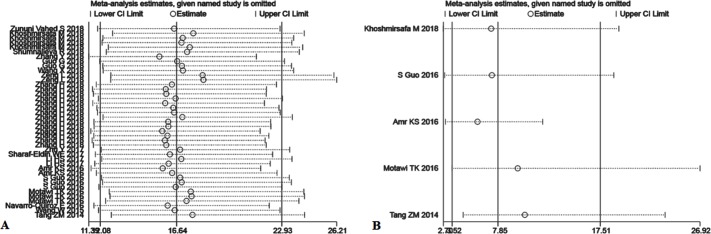
Sensitivity analysis of the individual trials on the results TmiRs and miR-21.(A) For the result of TmiRs, (B) For the result of miR-21. Not any single study was detected to incur undue weight in the analysis.